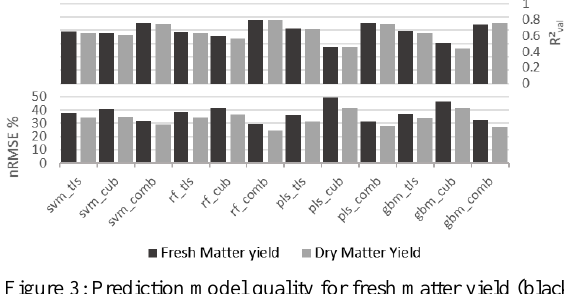
Figure 3: Prediction model quality for fresh matter yield (black) and dry matter yield (grey) for four machine learning methods (svm: support vector machines, rf: random forest, pls: partial least squares, gbm: gradient boosting machines) using only point cloud data (tls), hyperspectral data (cub), or both datasets together